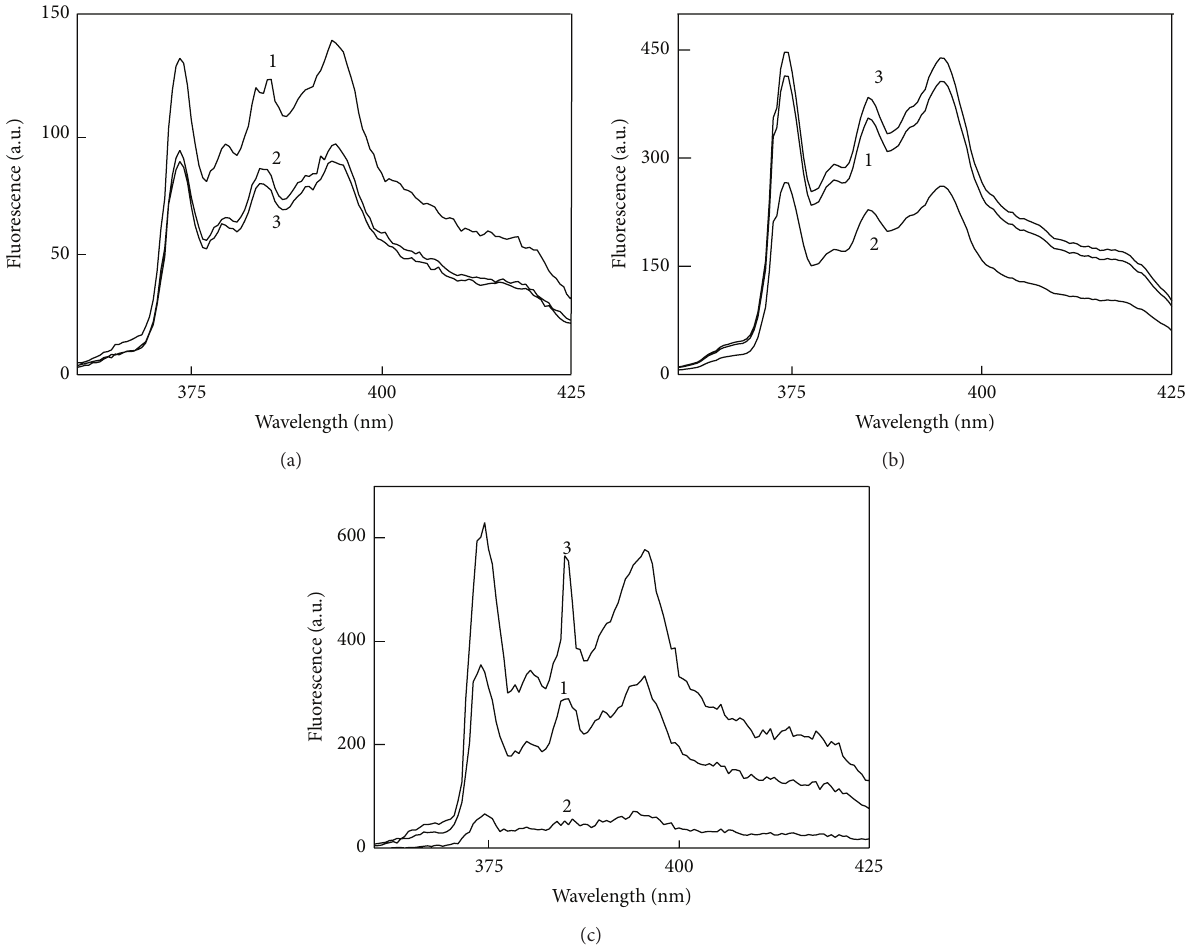
Figure 5: Fluorescence spectra of pyrene ( 𝜆 = 320 nm) in aqueous micellar solutions of (a) SDS, (b) CTAB, and (c) TX-100: (1) before exc sorption, (2) after sorption of the CDA fiber, and (3) on the CDA fiber.